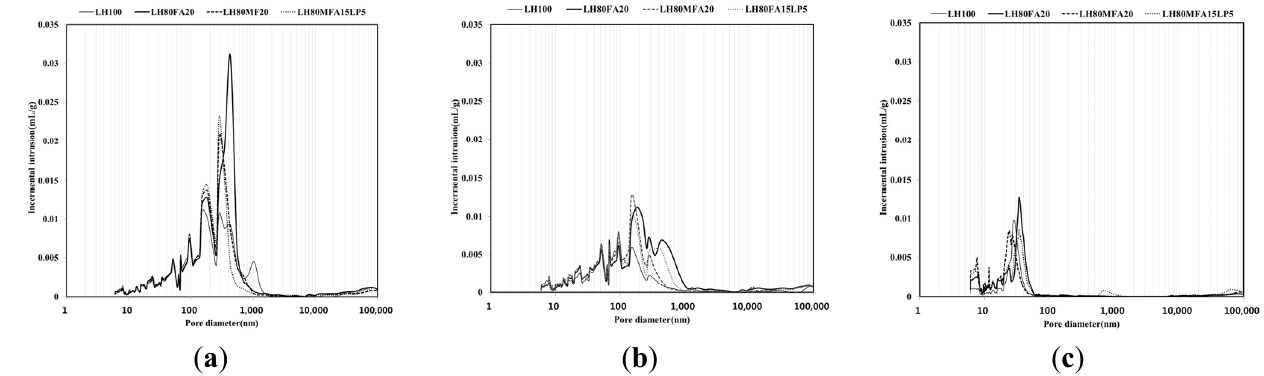
Figure 10. Pore-size distribution at: ( a ) 3 days; ( b ) 7 days; ( c ) 28 days.